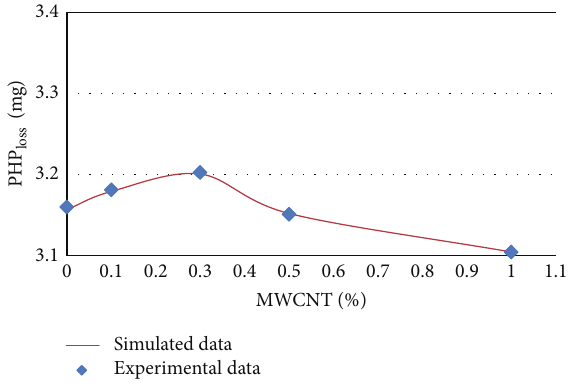
Figure 6: Experimental and simulated values of PHP loss for 14 days by artificial neural